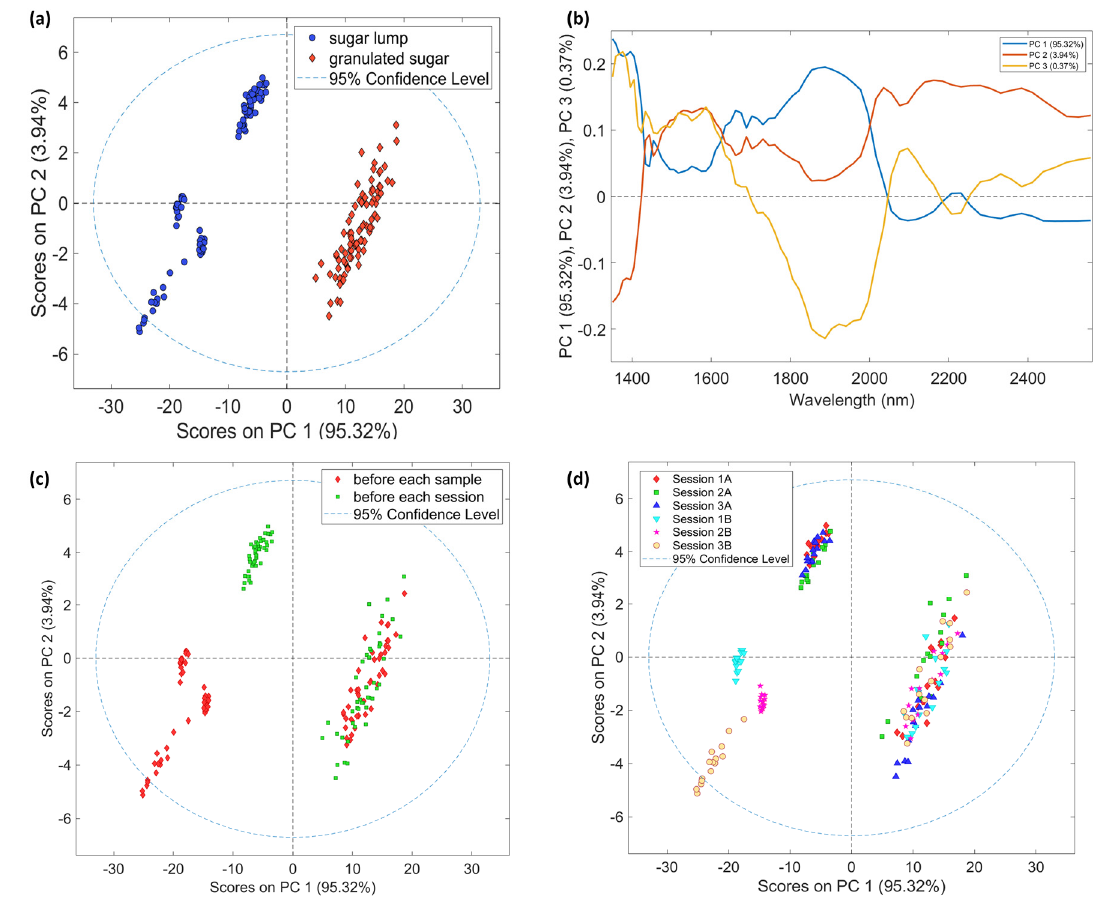
Figure 3. PCA models on NeoSpectra Scanner spectra. ( a ) Score plot PC1 vs. PC2 colored by samples; ( b ) Line loading plot; ( c ) Score plot PC1 vs. PC2 colored by time of background; ( d ) Score plot PC1 vs. PC2 colored by session and time of background where A and B in the legend stands for background before each sample and before each session, respectively.